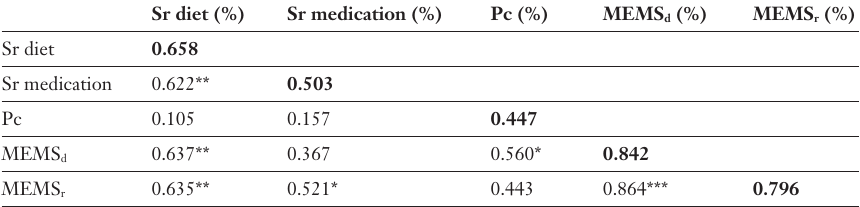
Correlation between different parameters of adherence to prescribed sulfonylurea medica- tion. Correlation coefficients are shown off diagonals, and squared multiple correlation coefficients (in bold) are shown in diagonals.